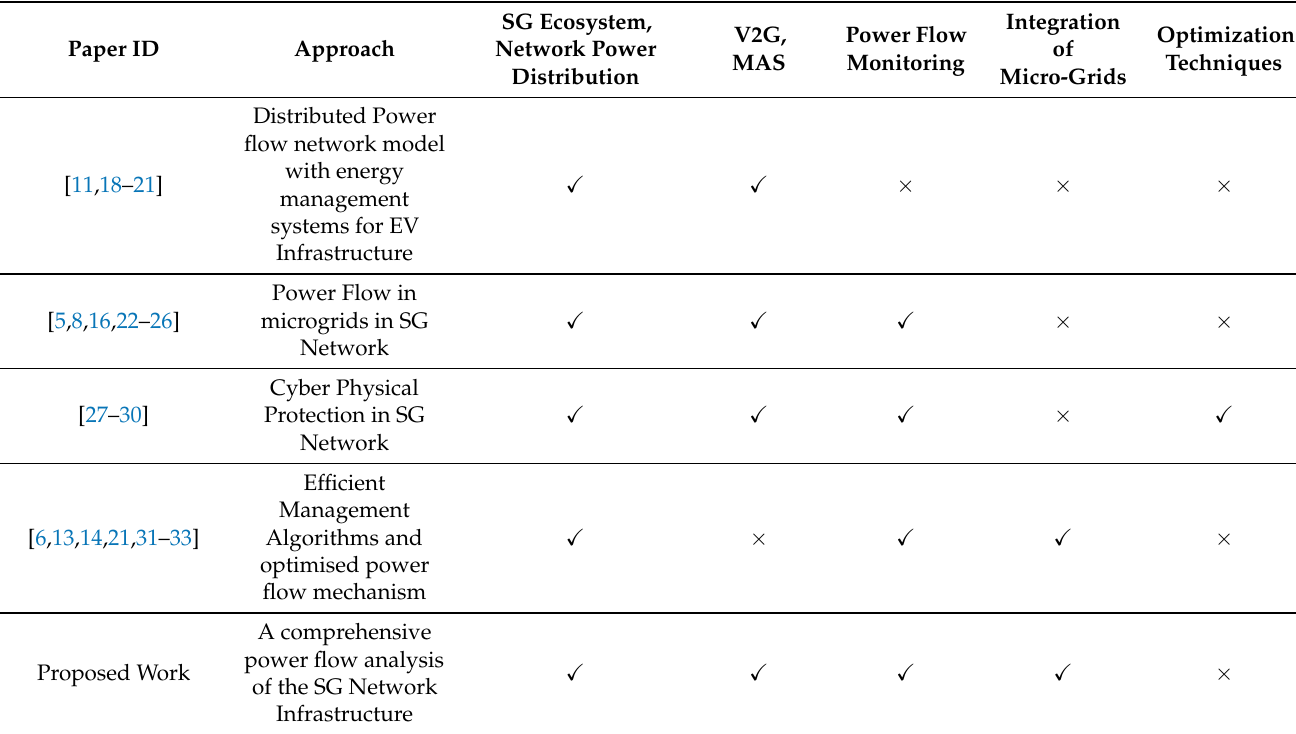
Table 1. Comparisons of Related works and Proposed